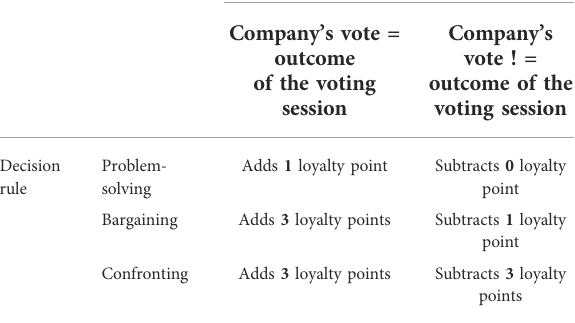
Alternative occurrences in a voting